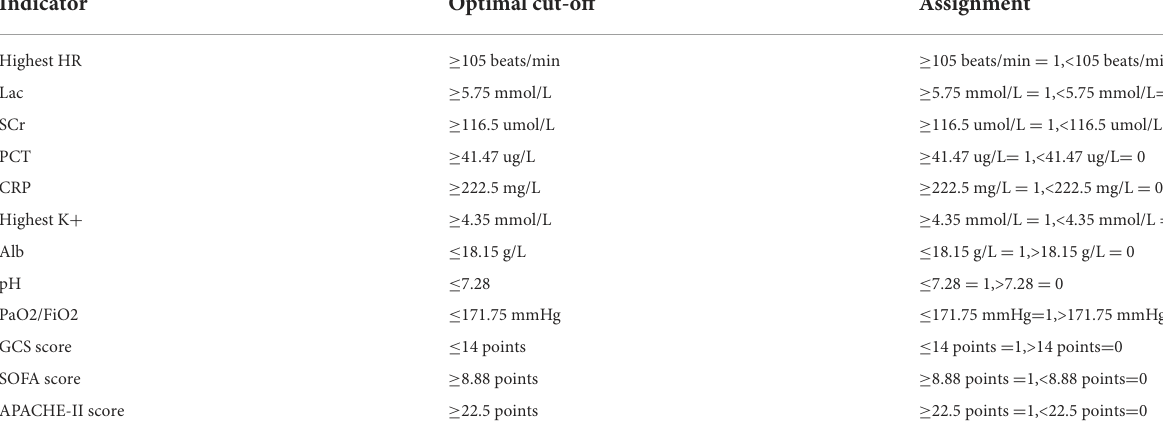
TABLE 2 The optimal cut-off value and assignment of continuous indicators. Indicator Optimal cut-off Assignment